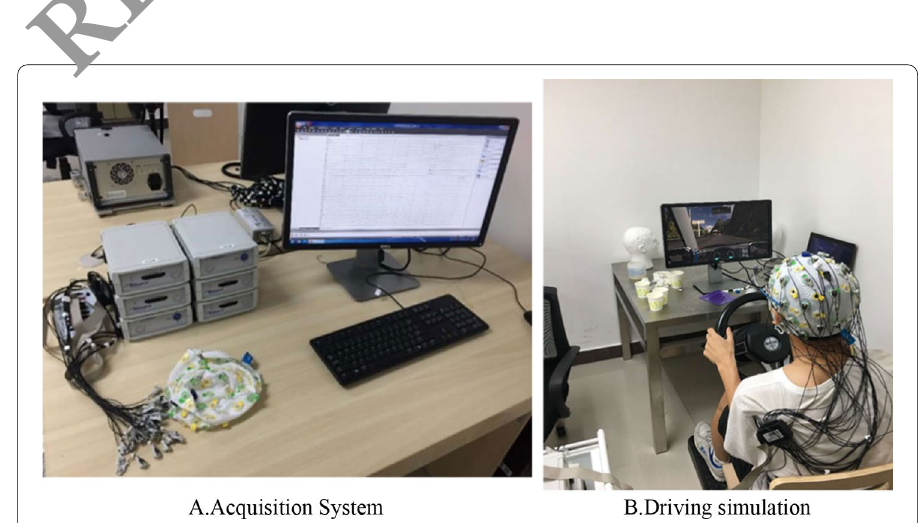
Fig. 2 Acquisition system and simulated